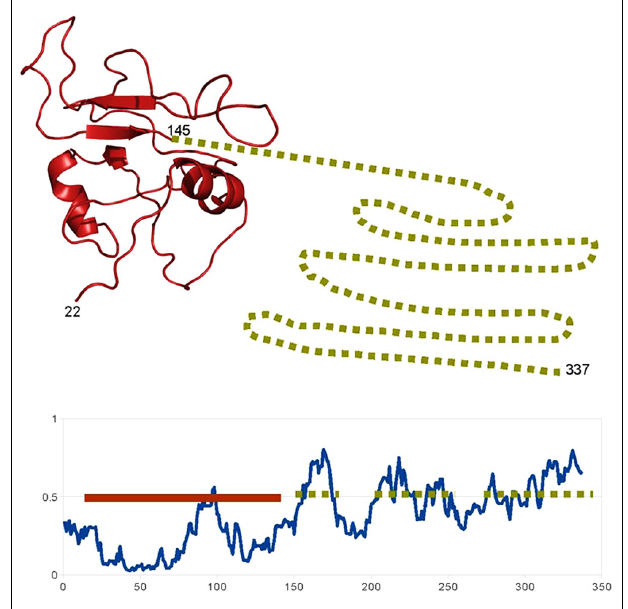
FIGURE 1 | Example of a highly disordered protein in A. thaliana . Schematic representation of the structural features of the “putative NAC domain-containing protein 94” (Uniprot: NAC94_ARATH).The disorder prediction of IUPRED (Dosztanyi etal., 2005) show that, according with the standard 0.5 threshold, most of the C-terminal part of the protein (from 150 to 337) is probably unstructured (dotted lines).The N-terminal DNA binding domain is probably structured and, indeed, a structural model can be generated based on the structure of a homolog (PDB:4dul_B, 62% sequence identity; solid line). So probably this protein “looks like” the representation above: a short structured DNA-binding domain followed by a long flexible disordered region, involved in the binding of different